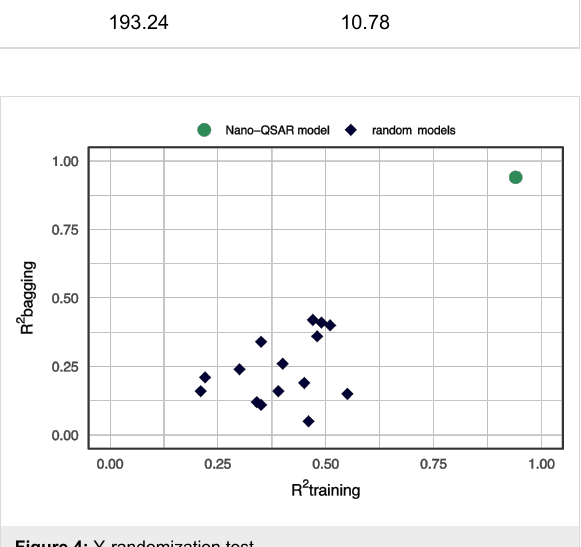
Figure 4: Y-randomization